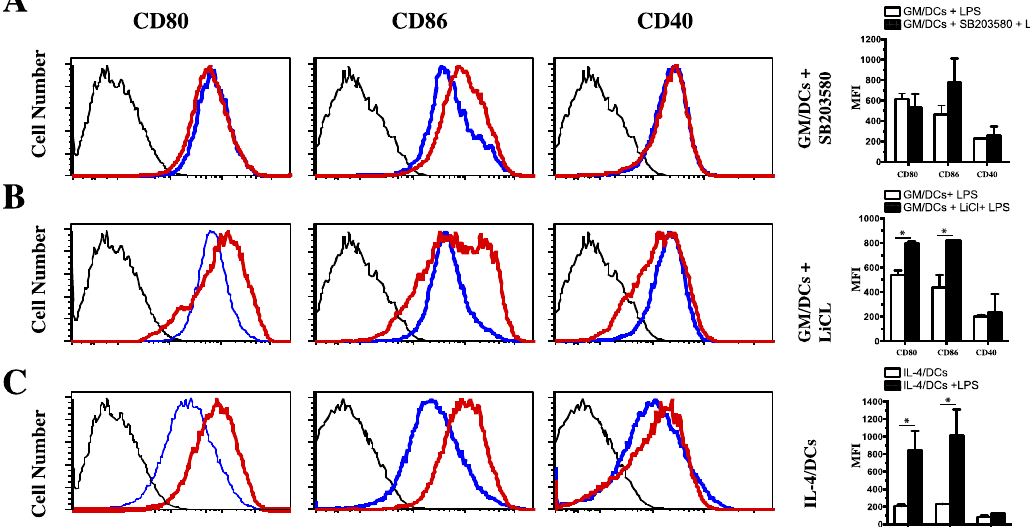
Figure 4. Role of p38 MAPK/CREB and GSK3b/CREB axis in regulating GM/DCs maturation status. Bone marrow-derived GM/DCs were preincubated with vehicle (DMSO, Blue thin line) or ( A ) p38 MAPK inhibitor (SB203580. 10 μM, red line) or ( B ) LiCl (10 mM, red line) before being exposed to with LPS (1 μg/mL for 48 h). Cells were harvested and the expression of CD80, CD86, and CD40 molecules was analyzed by gating on CD11c + cells using flow cytometry. ( C ) Bone marrow-derived IL-4/DC were left unstimulated (blue line) or were exposed to LPS (1 μg/mL for 48 h) (red line) and analyzed by flow cytometry. For all the panels, isotype controls are shown (dashed thin line). Expression levels of CD80, CD86, and CD40 cell surface markers are illustrated as mean fluorescence intensities (MFIs) are shown at right-hand sides of panels. Data are representative of two to four independent experiments. * p < 0.05, nonparametric unpaired Mann–Whitney test.